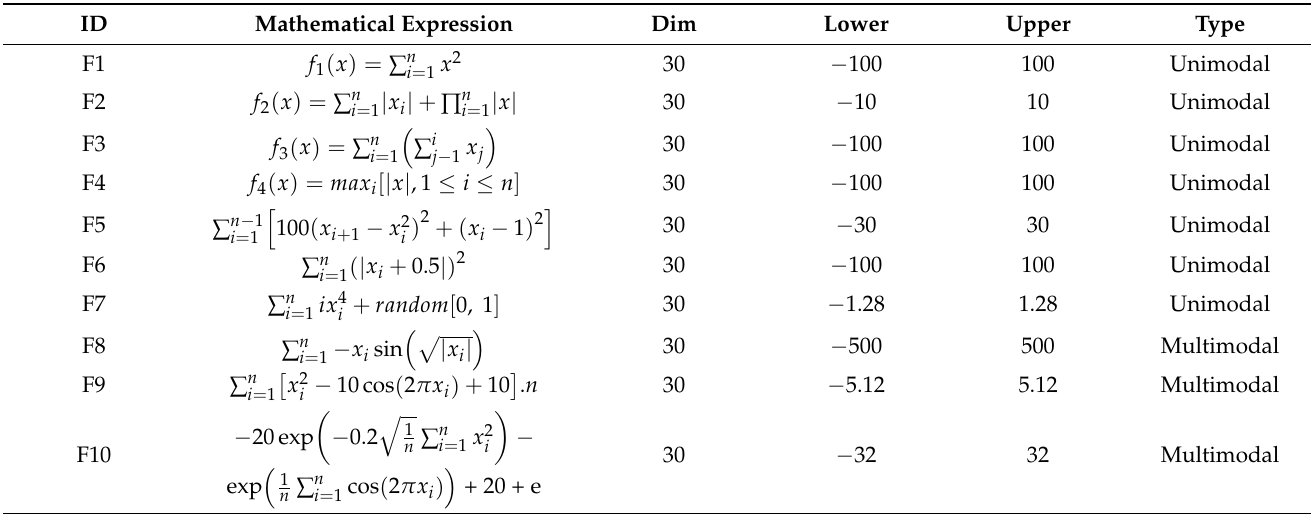
Table 1. Benchmark functions.